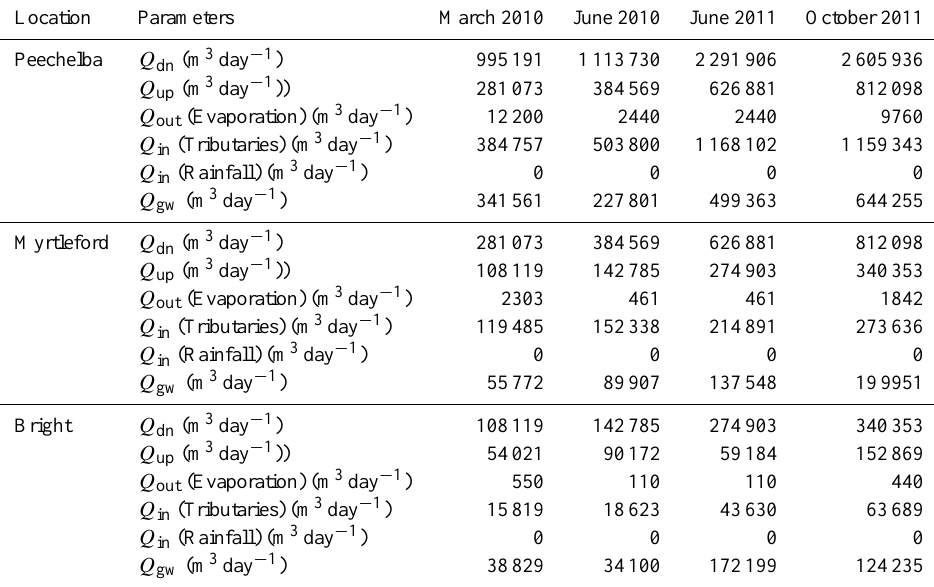
Table 6. Parameters used for calculating the net groundwater flux ( Q gw ) during low flow conditions by differential flow gauging using Eq. (8). Discharge data were obtained from Victorian Water Resource Data Warehouse (2011), and evaporation was estimated based on the surface area of river and data from Bureau of Meteorology